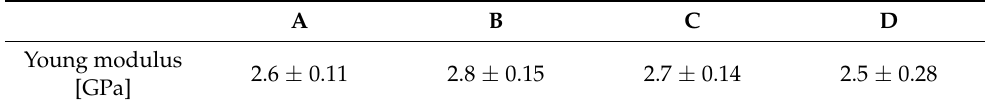
Table 4. Young modulus of the green filaments (powder + binder + additives).